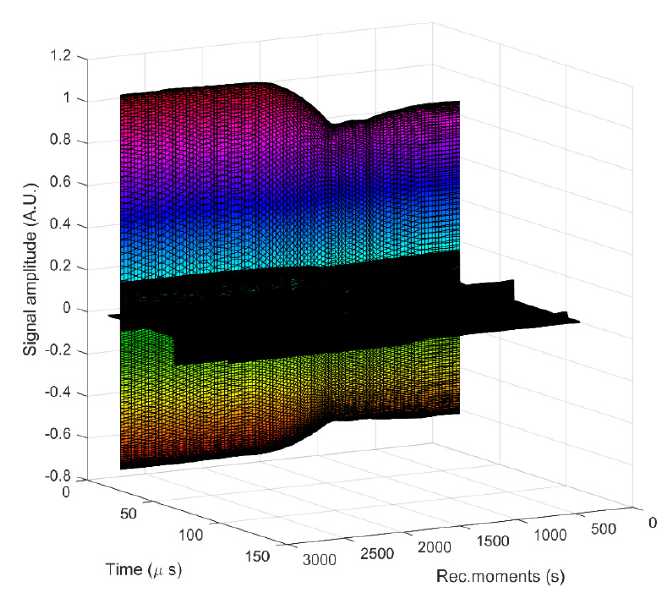
Figure 1. Recorded signals at 5 s recording interval. The increasing amplitudes of the first echo is visible in colors, whereas the second and third echo are significantly weaker (in black).